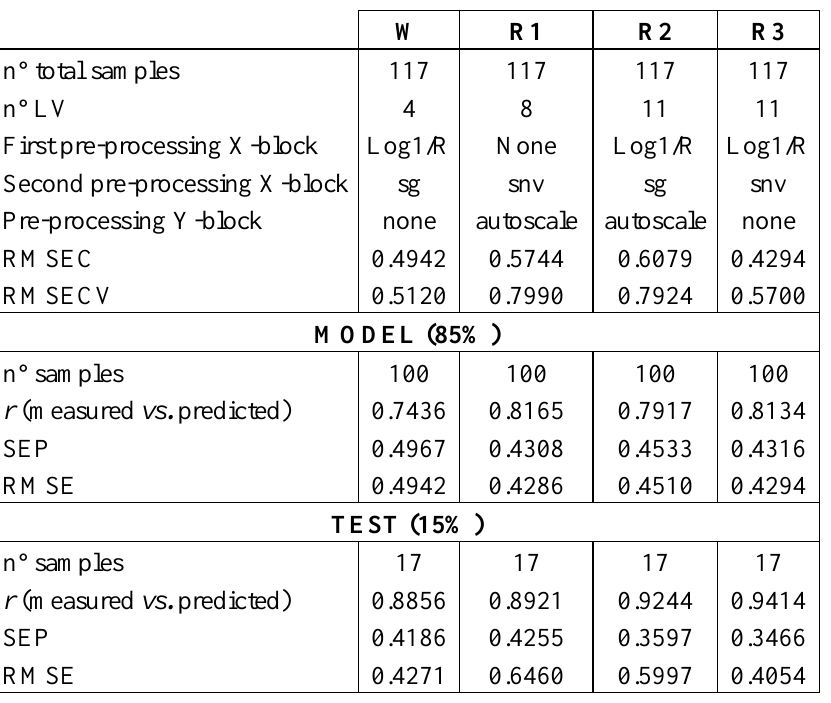
datasets (W = whole dataset, 125 vars; R1 = restricted dataset, first 92 vars, 400–694